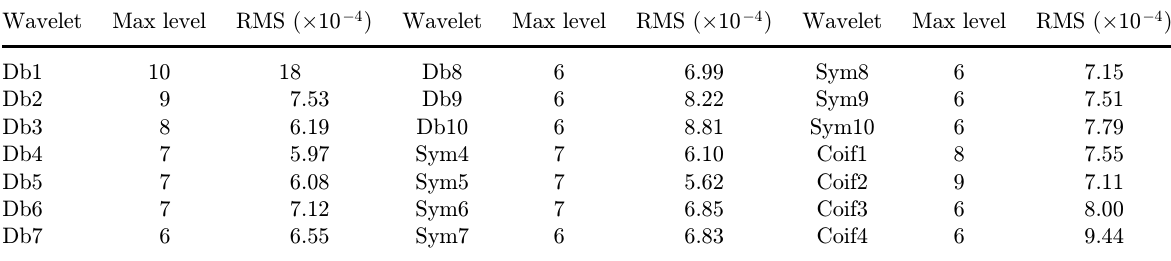
Table 2. RMS between original NIR spectrum and reconstructed spectra by WT with di®erent wavelets and a maximum decomposition level (CR ¼